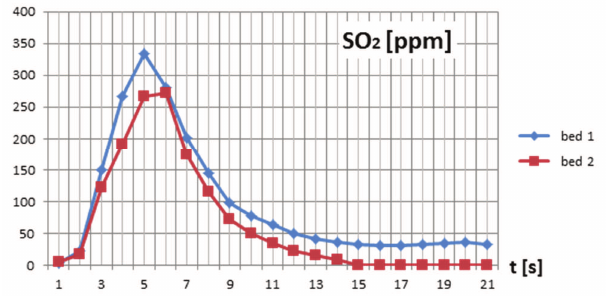
Fig. 4. Changes of sulfur dioxide concentrations while supplying the sorbent of a fixed bed The latter method of feeding the sorbent was its atomi- zation inside of the reactor chamber. In order to define the effectiveness of exhaust desulfurization using the dry meth- od, an experiment was held for three settings of the valve controlling the output of the sorbent. Thus, the output of the sorbent was regulated by throttling the control valve at a set pressure (around 0.9 bar) of air supply. The degree of throt- tling was unambiguously defined through the measurement of the core height along with the wheel above the valve frame. Three settings were assumed, i.e.: ¾, ½ and ¼ of a core valve stroke. Additionally, in order to define the de- gree of exhaust stream dilution by the air supply and thus its impact on concentration values of particular toxic com- pounds, including of course the impact on sulfur oxides, the reactor column was fed only with air supply for the ¾ stroke setting. The view of the valve is shown in Fig. 5.